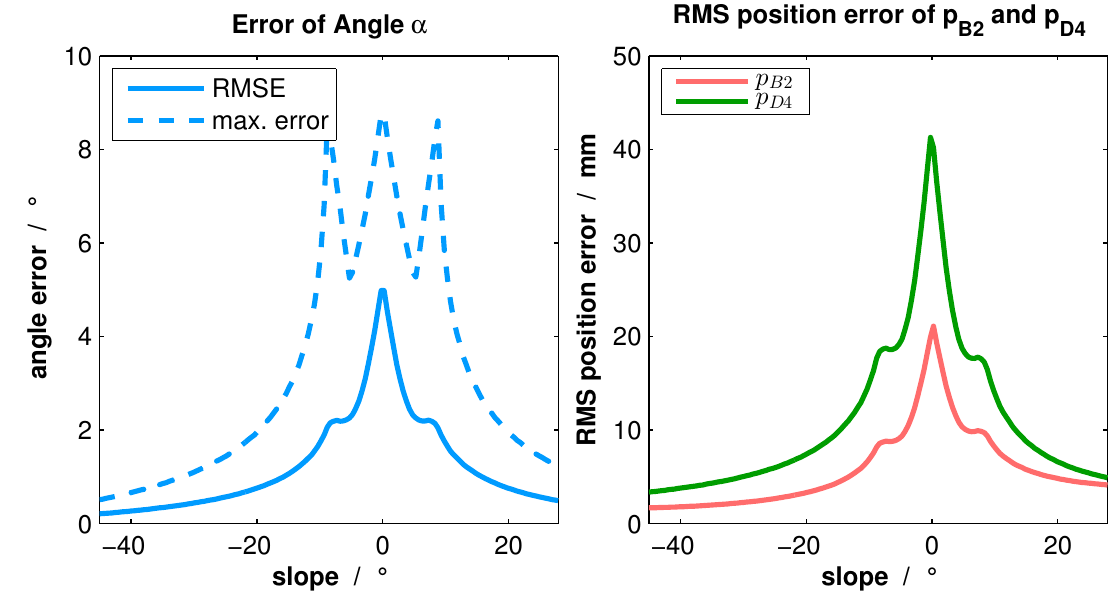
Figure 5. Angle estimation error due to small errors of 3D feature point extraction ( left ) and the resulting segment errors ( right